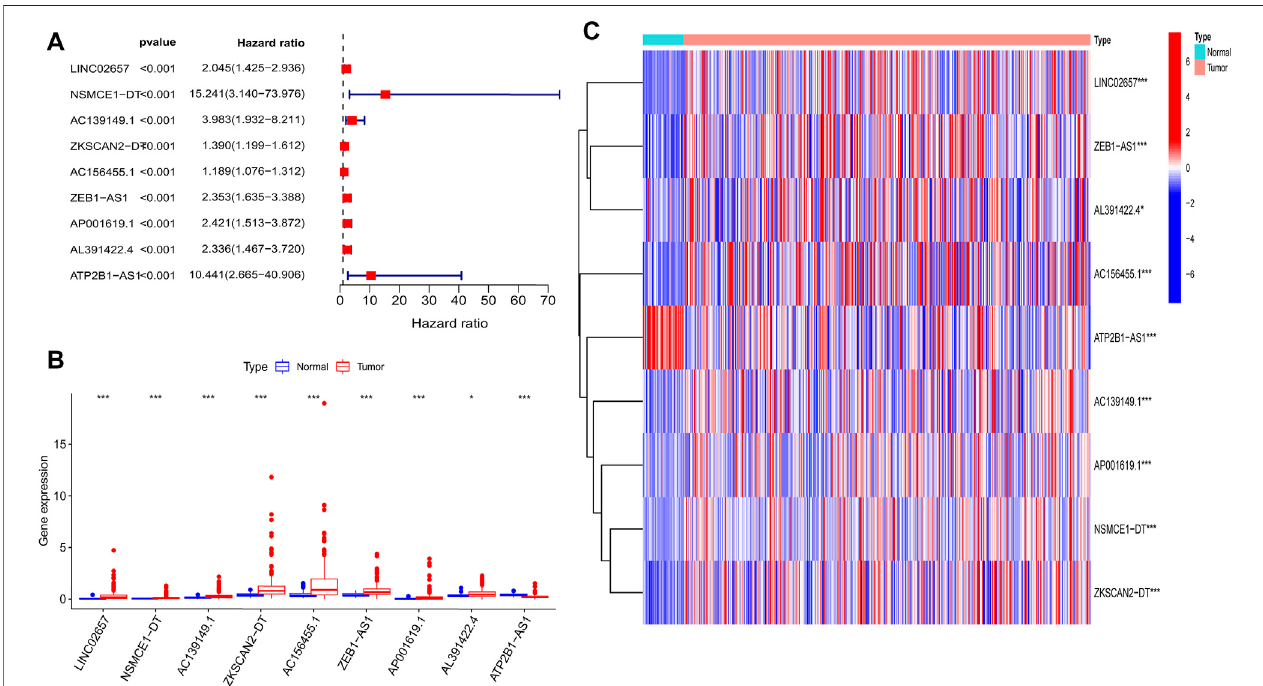
FIGURE 2 | Nine prognostic m 6 A-related lncRNAs of COAD. (A) Forest map of nine prognostic m6A-related lncRNAs by univariate Cox regression analysis. Red represents high risk, while green represents low risk; all of them were high risk. (B) Boxplot of the different expressions of the nine prognostic related lncRNAs among tumor and normal tissue; the expression of AC156455.1 in tumor tissuewas signi fi cantly higher than that ofthe normal group. (C) Heat map ofthe different expressions of the nine prognostic related lncRNAs among tumor and normal sample. The ordinate represents the lncRNAs, while red represents high expression and blue represents low expression. The abscissa represents the sample. * p < 0.05, ** p < 0.01, *** p <